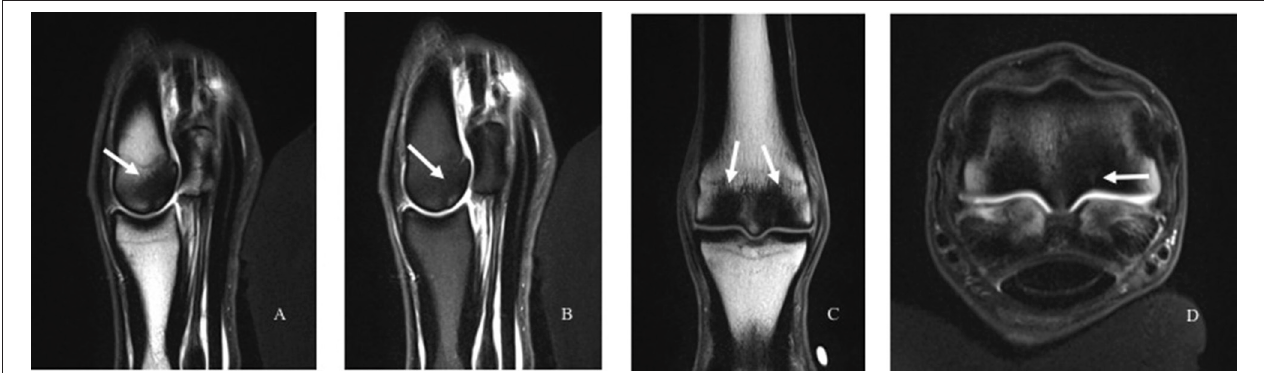
FIGURE 3 | Images of subchondral bone injury as detected using magnetic resonance imaging (MRI). An intermediate-weighted T1 TSE sequence with (A) and without (B) fat suppression in the sagittal (A, B) , dorsal (C) , and transverse (D) planes. There is marked subchondral and trabecular bone sclerosis in the palmar aspect of the third metacarpal condyle (white arrows), with the lateral condyle slightly more affected than the medial condyle. There is a fissure visible within the bone on the palmar-axial aspect of the lateral condyle that also exhibits increased signal ( D ,